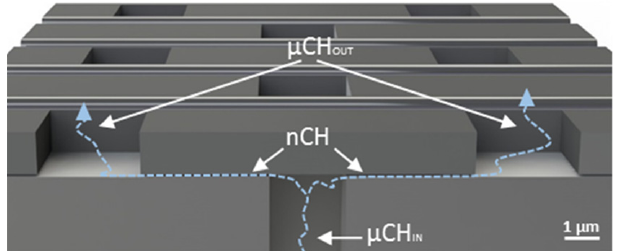
Figure 7. Cross section of the nanofluidic membrane. The membranes used in the manuscript have nanochannels with 3 µ m width and 3 µ m length. The microchannels